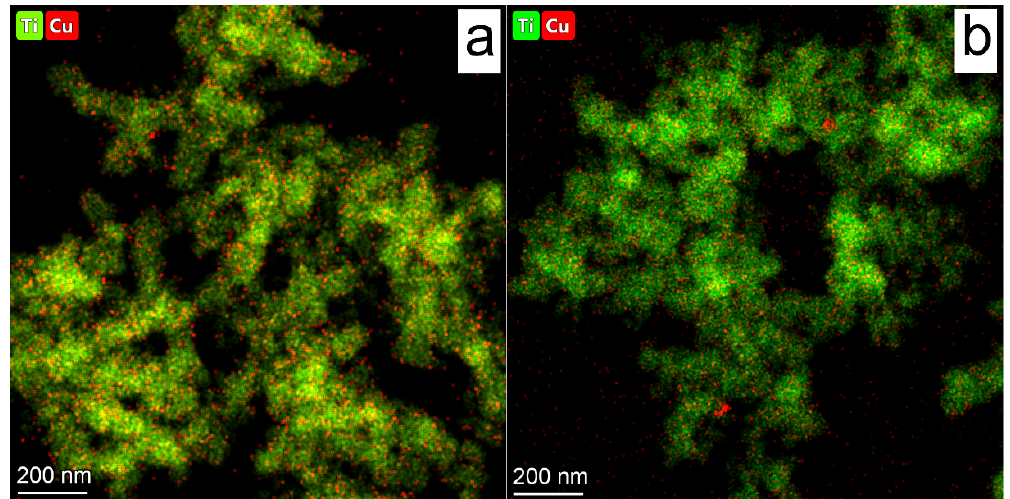
Figure 8. EDX mapping of ( a ) fresh Cu/TiO 2 700 sample and ( b ) after irradiation for 120 h or 5 runs under LED-400 nm.